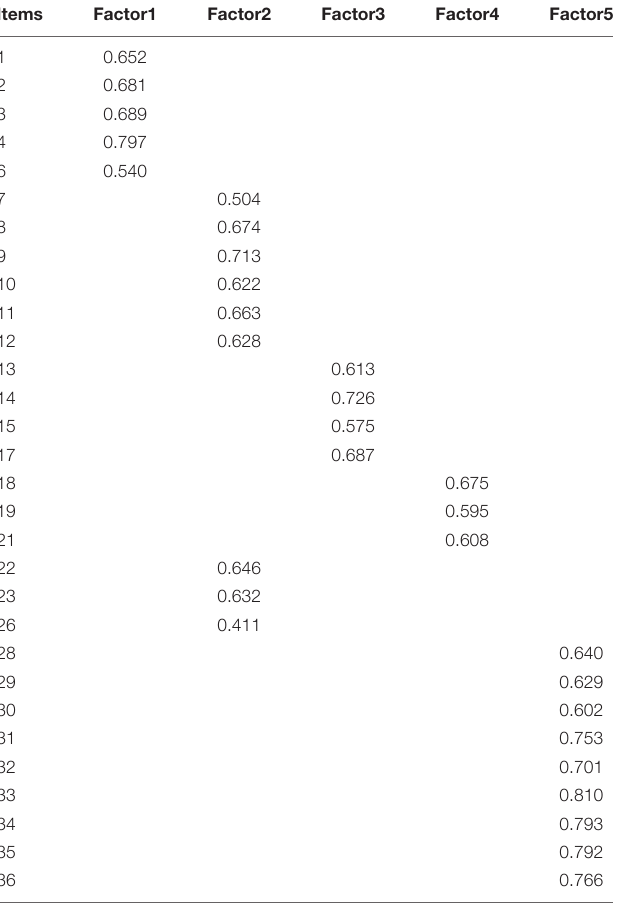
TABLE 5 | Rotated factor loadings of the exploratory factor analysis with 30 items ( N = 958). Items